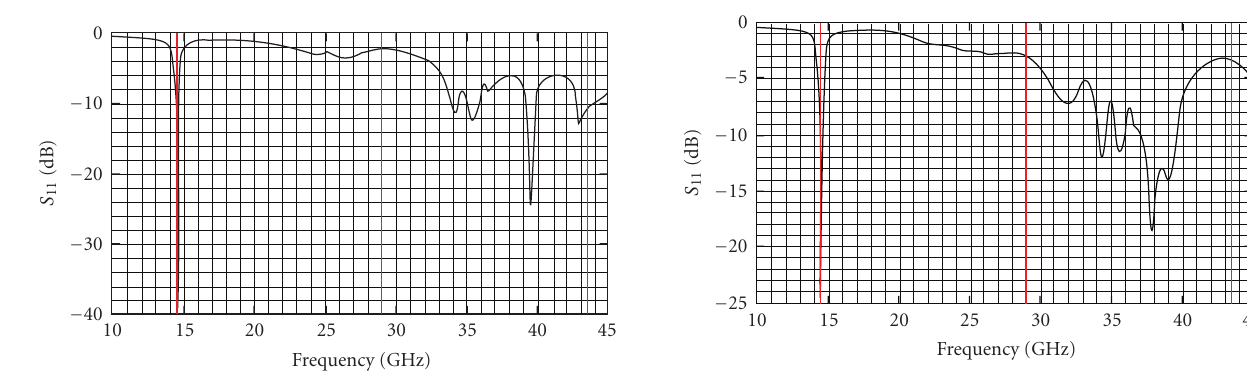
Figure 6: Return loss of the modified structure exhibiting the in- slot parasitic element as sketched in Figure 5.